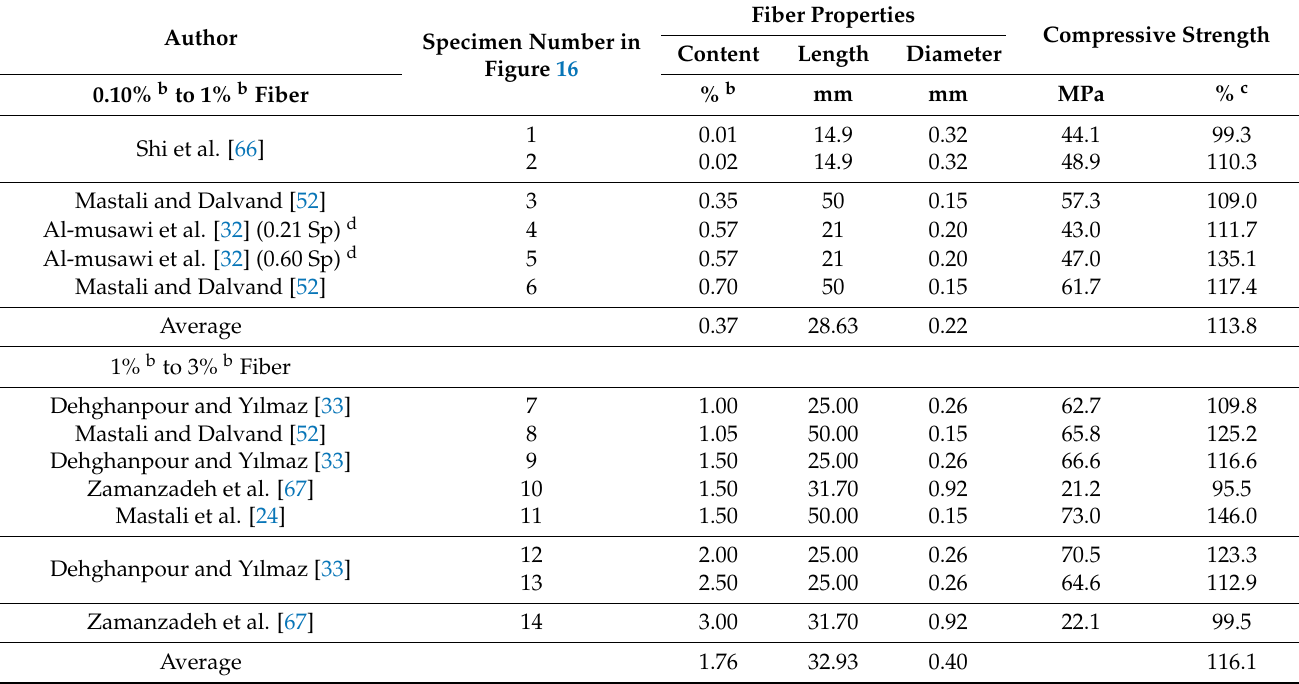
Table 12. Results of compressive strength’s percentage comparison and fiber properties of the cement mortar incorporating RSF by volume